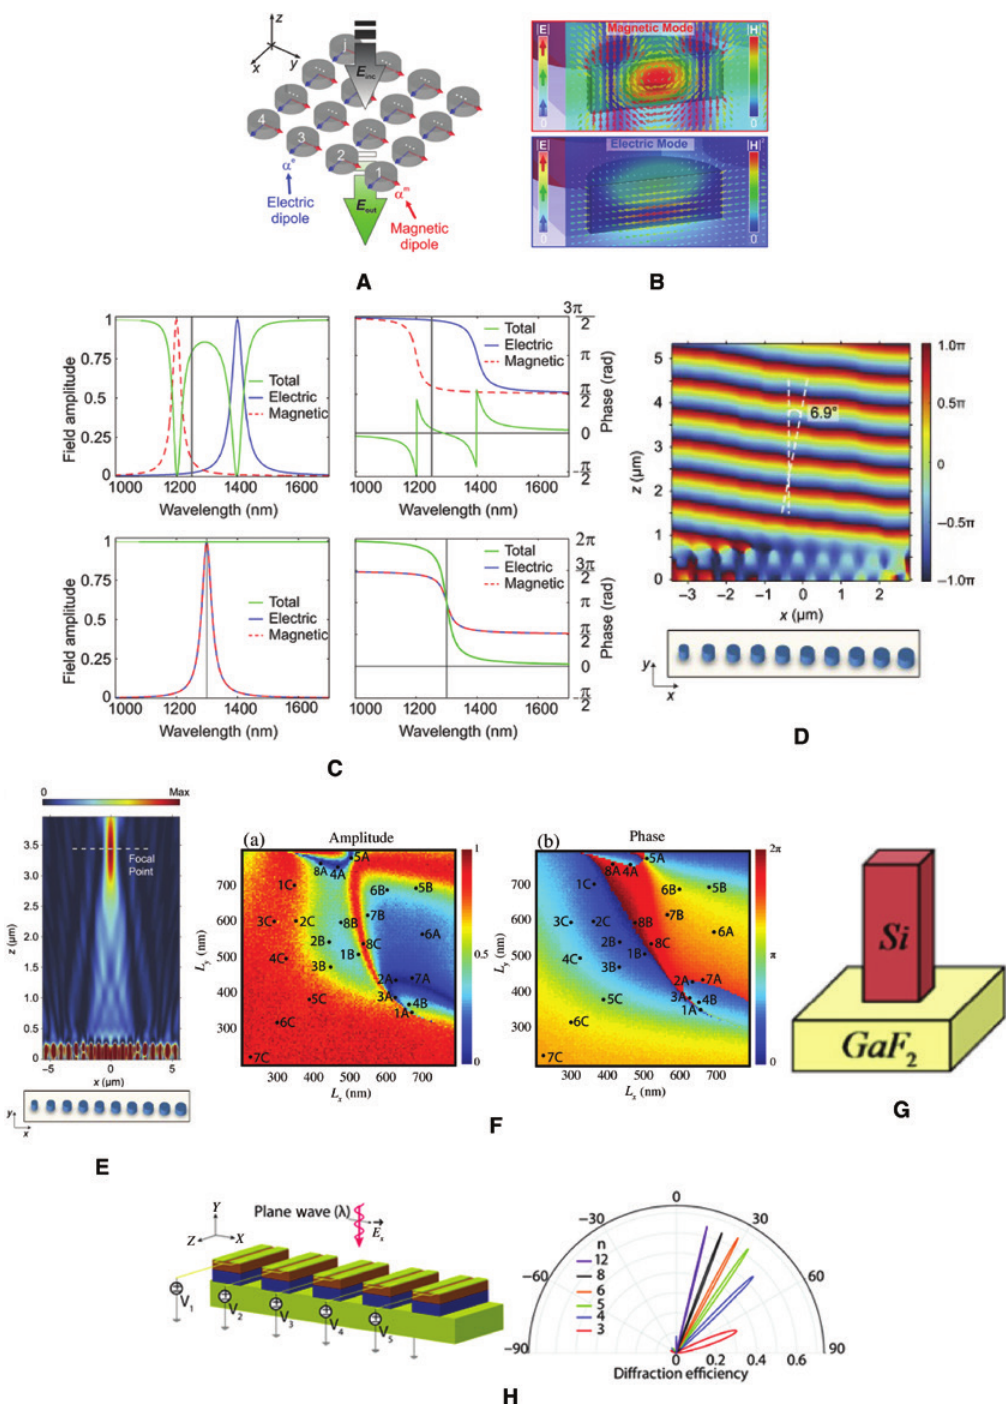
Figure 22: All-dielectric optical Huygens’ metasurfaces. (A) An array of silicon nanodisks that forms an all-dielectric optical HMS (obtained from [103]) and (B) the corresponding electric and magnetic dipole modal profiles (obtained from [103]). (C) The transmission amplitude and phase variations that demonstrate the effect of separating/ collocating the electric and magnetic resonances (obtained from [103]). The demonstration of (D) arbitrary beam refraction and (E) focusing with an array of silicon nanodisks (obtained from [105]). (F) The variation of transmission magnitude and phase as a function of lengths ( L and widths ( L ) of a silicon nanoblock and the design points that are used for constructing a focal spot with desired FWHM and SLL (obtained y from [106]). (G) An optically tall all-dielectric unit cell that utilizes waveguiding effects for obtaining 2 π phase shift (obtained from [107]). (H) A reconfigurable metasurface that dynamically engineers magnetic dipole resonance of InSb blocks that sit on a metallic backplate for dynamic reflected wavefront manipulation (obtained from